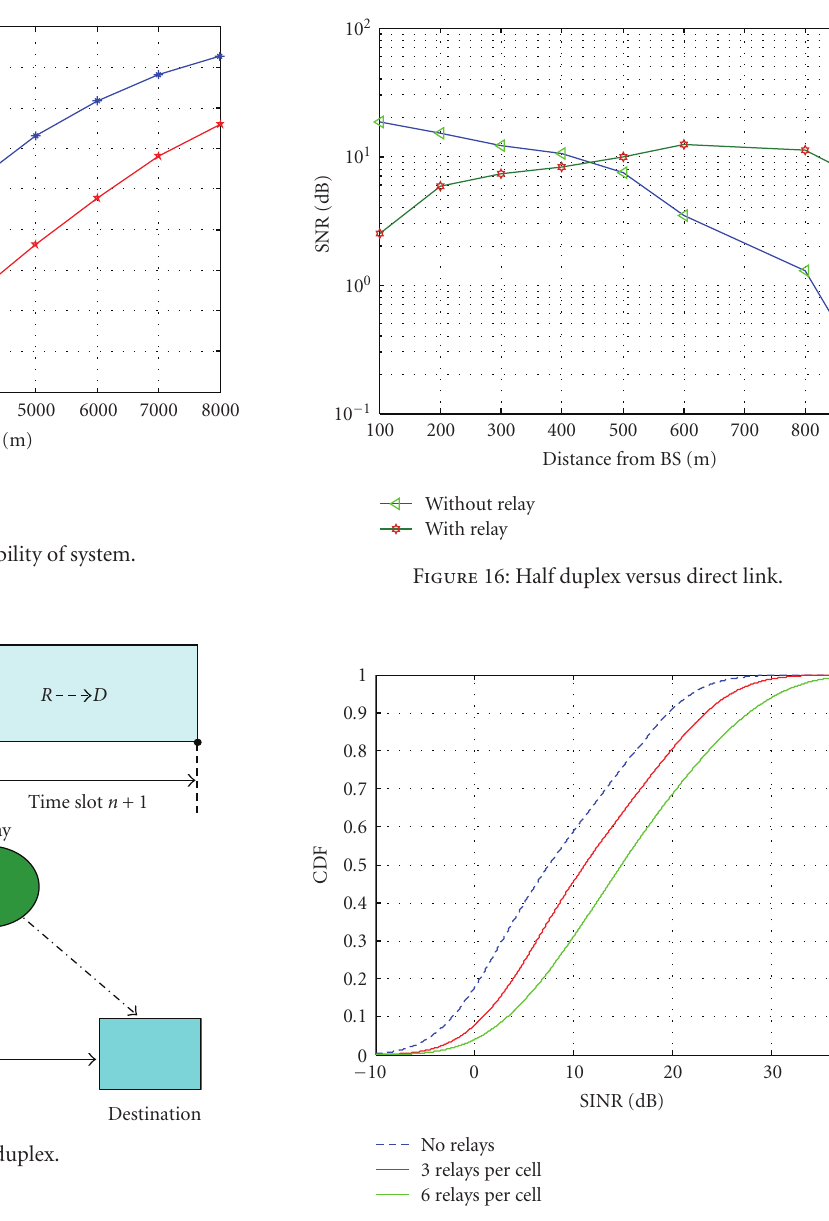
Figure 17: SINR at the edge of